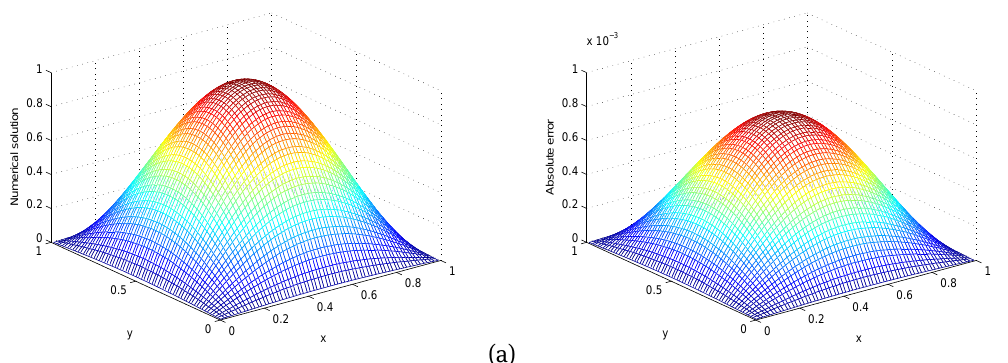
Figure 4: Numerical solution (a) and global error (b) for Example 4 with γ = 1.9 at T = 1 ( h = 1/32, τ = 1/32